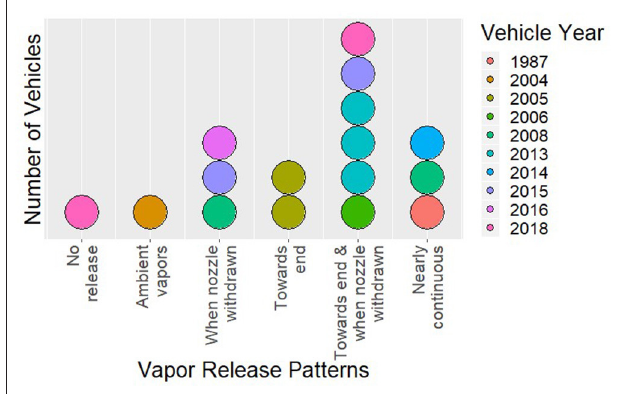
FIGURE 1 | Dotplot depicting the number of vehicles in each vapor release category (each dot represents one vehicle), with year delineated by color.